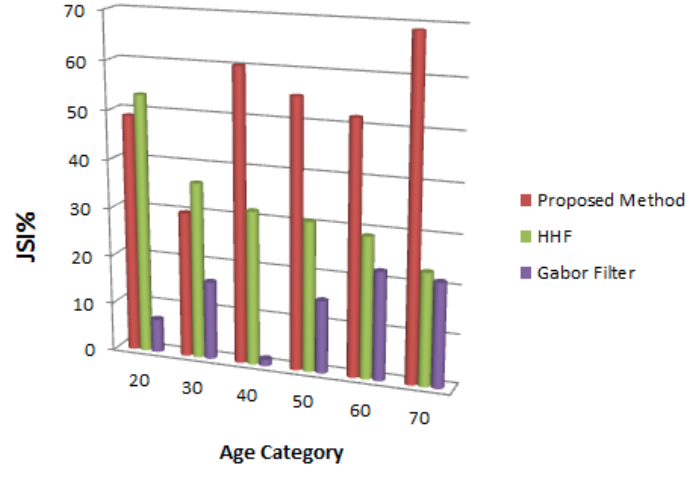
Figure 8. A comparison of the wrinkle detection algorithms on different age